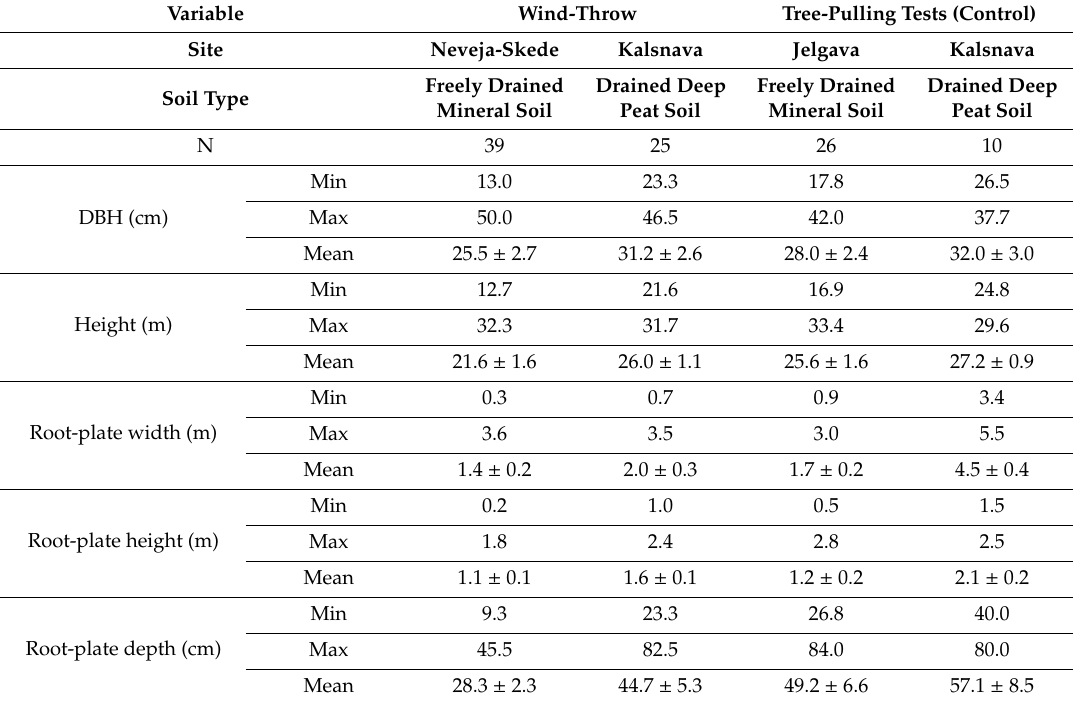
Table 1. Dimensions of sampled